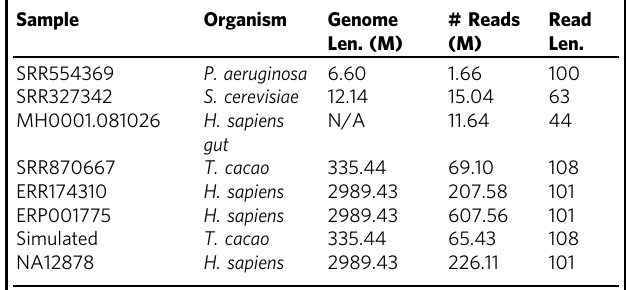
Table 1 The MPEG HTS benchmarking data